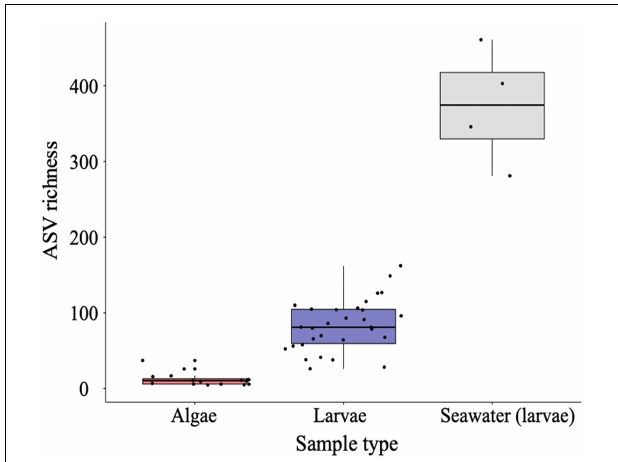
FIGURE 6 | Boxplots of amplicon sequence variant (ASV) bacterial richness evaluated in Chaetoceros calcitrans (CC) and Tisochrysis lutea (T-Iso) microalgae, Crassostrea gigas larvae, and rearing seawater datasets. All treatments and days of sampling data were pooled. Median values and the lower (25%) and upper (75%) quartiles are presented. Whiskers indicate the minimum and maximum values, while outliers are displayed as dots.